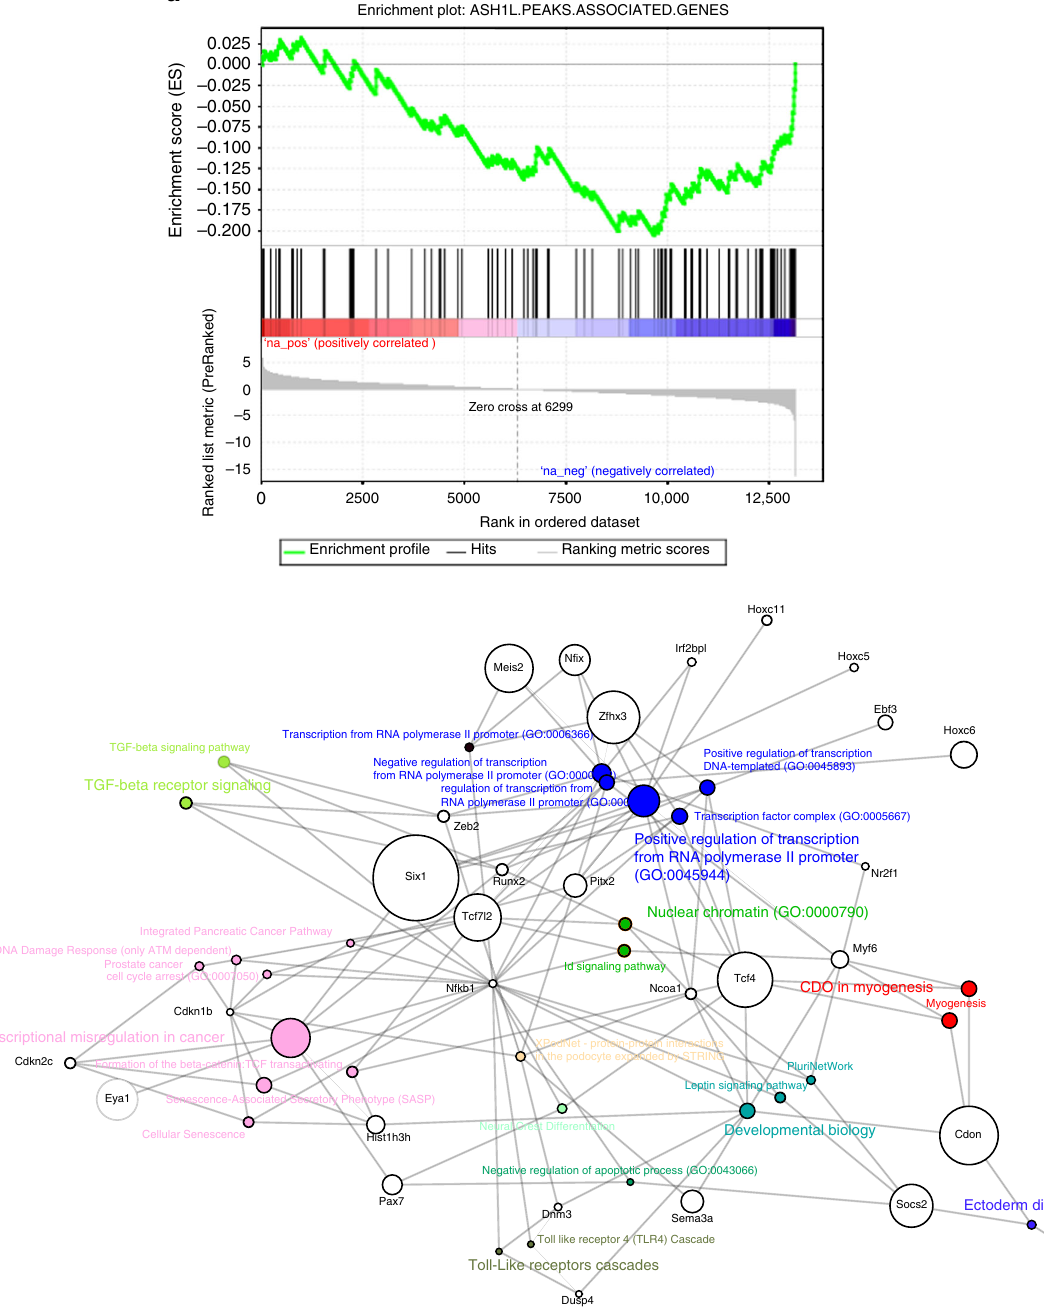
Fig. 6 Identi fi cation of direct Ash1L targets. a Gene set enrichment analysis enrichment plot for Ash1L ChIP-seq peak-associated genes ( n = 146, 96 expressed in myoblasts) obtained from the gene list pre-ranked according to the log 2 FC in myoblast KD vs. NS RNA-seq experiment. The leading edge analysis identi fi ed 45 genes as signi fi cantly downregulated and correlated to Ash1L binding. b Bipartite graph showing signi fi cantly enriched categories (KEGG, Biocarta, WikiPathways, Reactome, GO BP/MF/CC) (FDR <0.05, Z -score < − 1.75, and n ≥ 3) and their associated genes within the 45 direct targets identi fi ed with the GSEA analysis in a . The size of the gene nodes is proportional to the log 2 FC of downregulation, while the size of the category nodes is proportional to the signi fi cance of enrichment ( − log 10 Adj. p identi fi ed many secreted, membrane, signaling, or cytoskeletal proteins belonging to the myoblast fusion machinery 8,10 . On the contrary, only few transcription factors involved in myoblast fusion are known 28 – 31 . Notably, no epigenetic regulator of myoblast fusion has ever been described. Ash1L (Kmt2h) is a histone methyltransferase belonging to the Trithorax group. It positively regulates gene transcription by